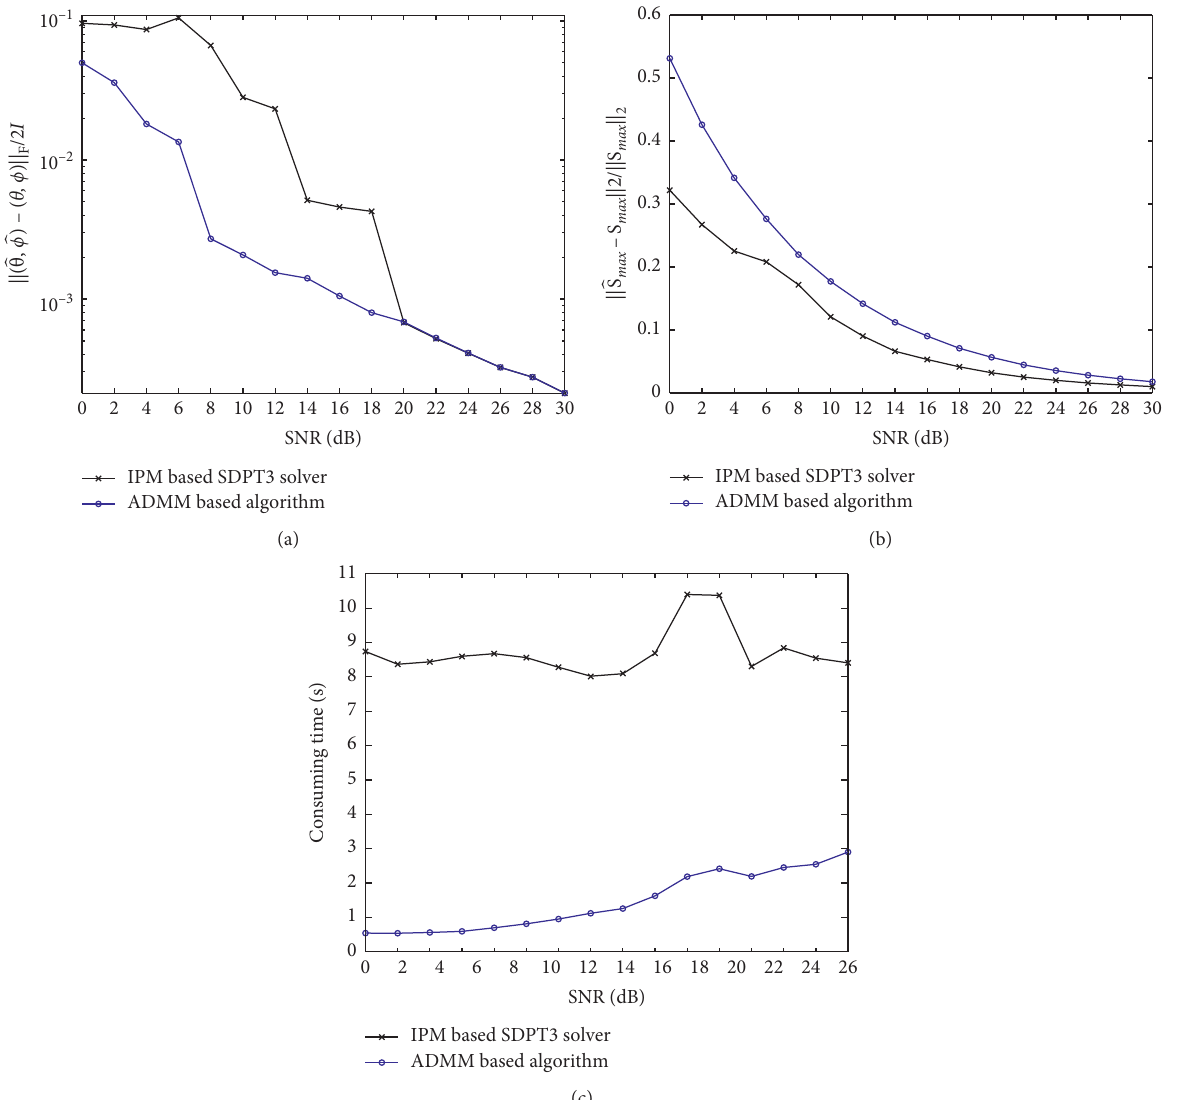
Figure 2: Curves of (a) ‖[ 􏽢 θ , 􏽢 ϕ ] − [ θ , ϕ ]‖ array with 64 microphones is